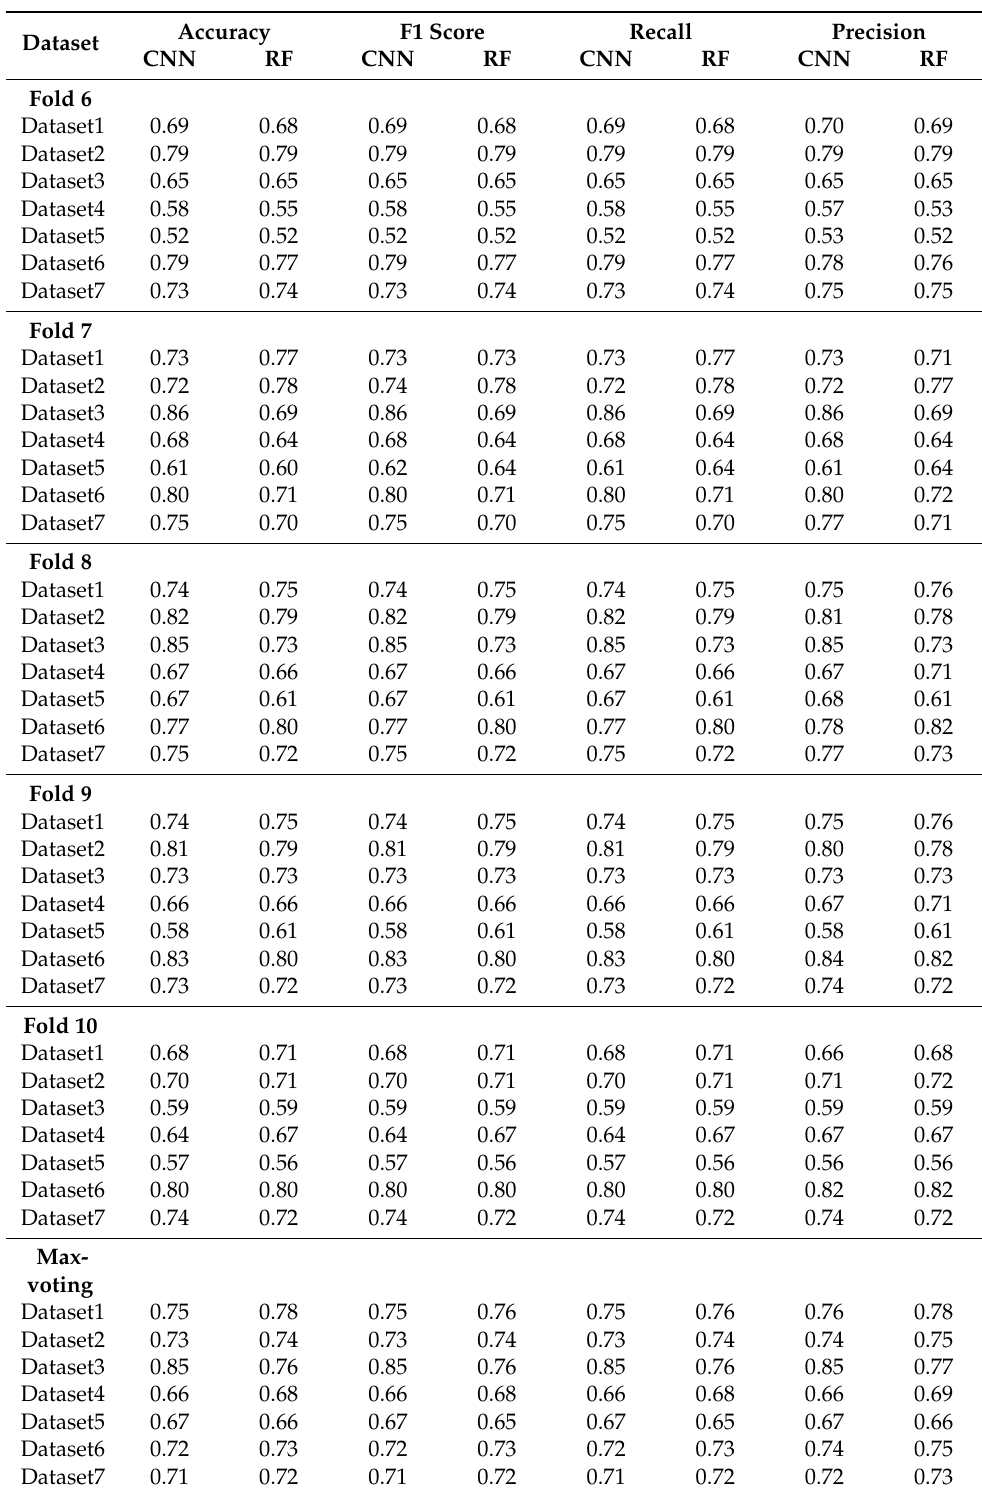
Table 7. Performance metrics CNN vs. RF (from Folds 6 to 10 and voting based on 10